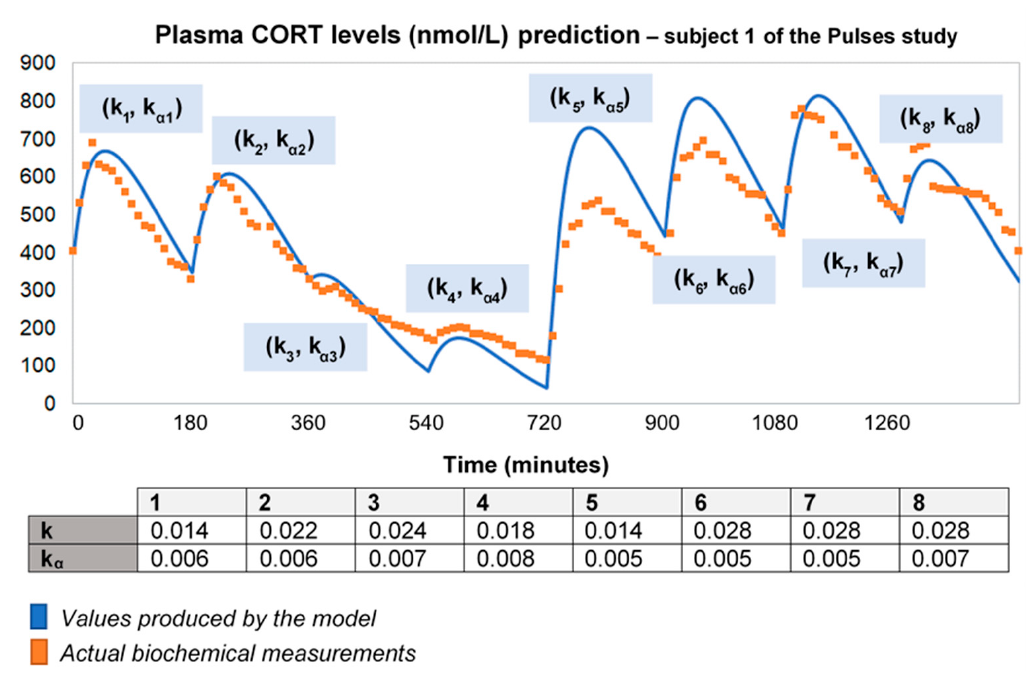
Figure 2. To improve the fitting of the model for longer time intervals, we recalibrated the absorption and clearance rates every 3 h. Specifically, we used the model to produce a curve for every 3-h interval, which was then fitted to data with different (k, k α ) pairs for each curve. Then, we concatenated the curves creating a piecewise fitted simulation with a duration of 24 h. Time points of delivery (magnitude of doses): 0 min (2.3 mg/230 µ L), 180 min (2.3 mg/230 µ L), 360 min (0.5 mg/50 µ L), 540 min (0.5 mg/50 µ L), 720 min (4 mg/400 µ L), 900 min (4 mg/400 µ L), 1080 min (4 mg/400 µ L) and 1260 min (2.3 mg/230 µ L). As before, plasma cortisol measurements from Subject 1 of the Pulses study were used. CORT: cortisol; k: clearance rate; k α : absorption